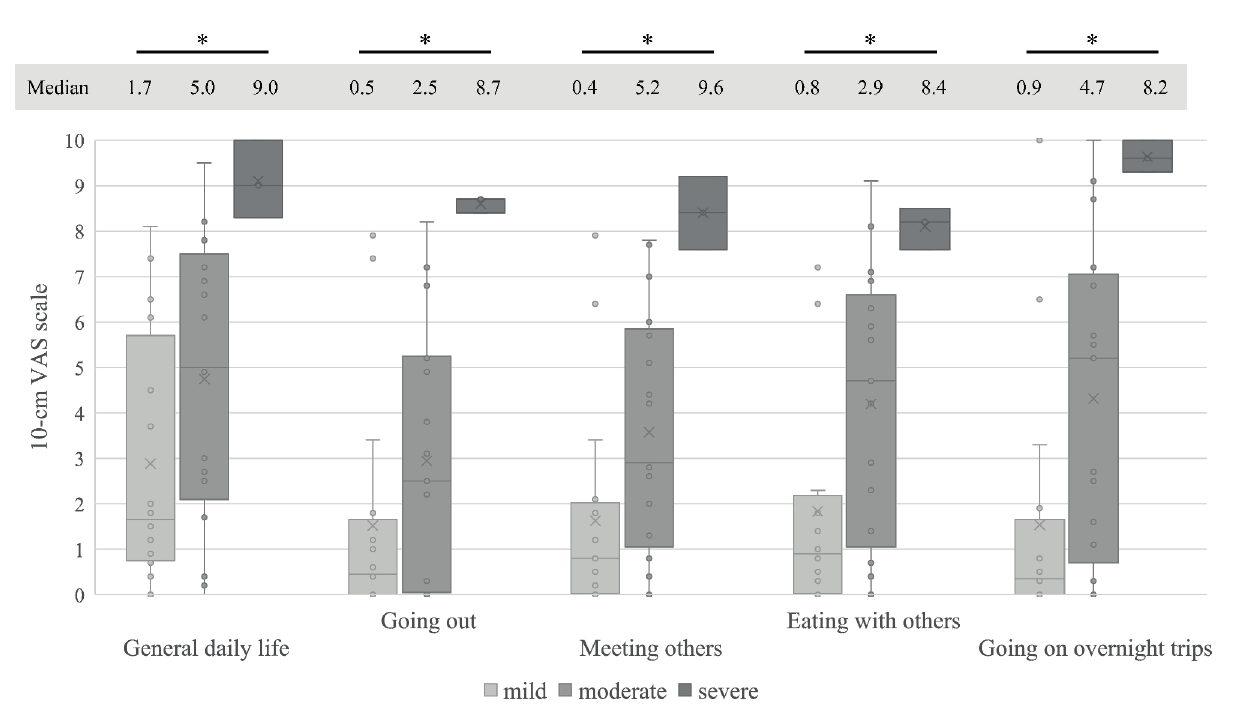
Figure 3. Limitations in the activities of daily living by the severity of epistaxis (10 cm-VAS scale). Each box shows the inter-quarter range. The median VAS score (cm) for the range of actions in each group is presented at the top of the diagram. VAS, visual analogue scale. Comparison of each group was performed using